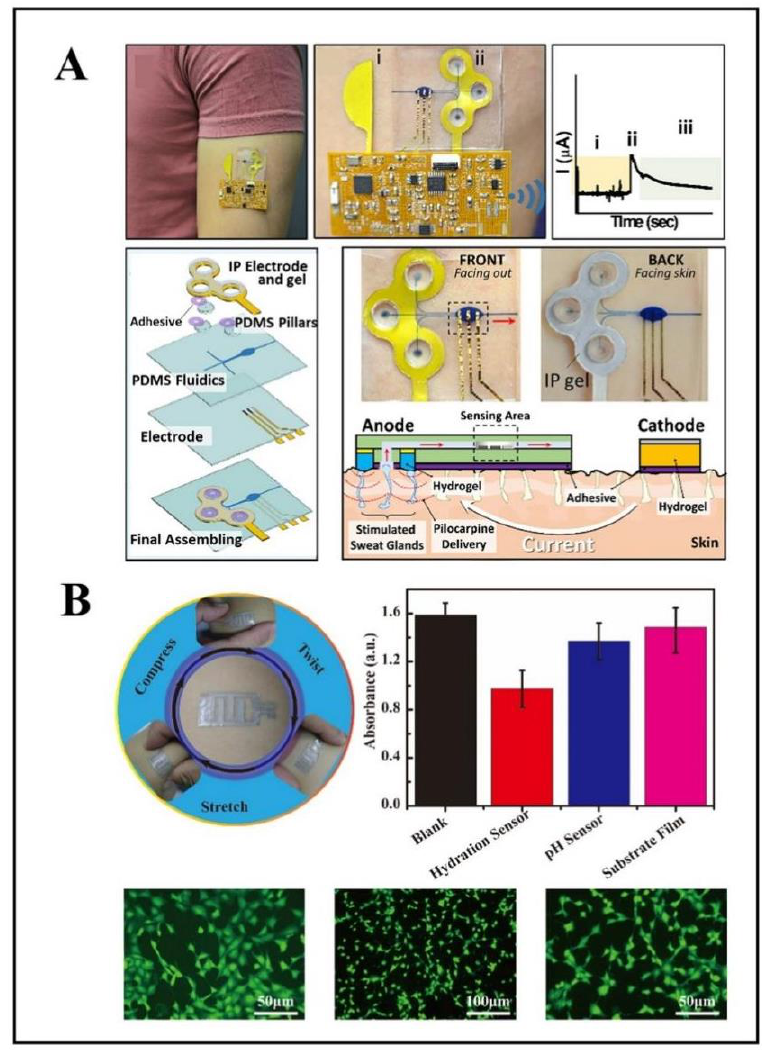
Figure 6. Examples of wearable flexible sensors for glucose and pH monitoring. ( A ) An all-in-one device that integrated sweat stimulation, collection, and analysis, (i) initial current when there is no sweat, (ii) the current of sweat coming into contact with the electrodes, (iii) the electrochemical response of the sensor. Reprinted with permission from ref. [96]. Copyright 2022, SpringerLink. ( B ) A non-invasive and biocompatible wearable sensor, reprinted with permission from ref. [102]. Copy- right 2021, SpringerLink. Table 1. Summary of flexible sensors for vital sign monitoring.